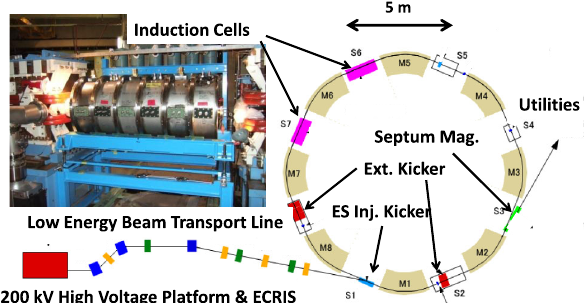
FIG. 1 (color online). Outline of the KEK digital accelerator, where ICs for confinement and acceleration are placed at S6 and S7, respectively. Rectangular shapes on the low-energy beam transport line denote bending, focusing, and defocusing magnets by blue, yellow, and green.